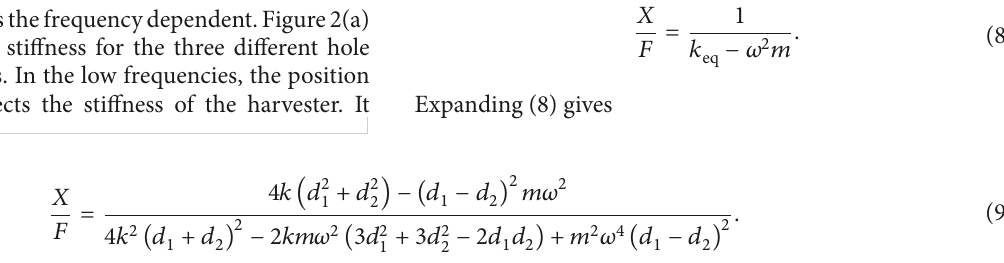
Substituting 𝐽 = (1/4)𝑚(𝑑 1 − 𝑑 2 ) 2 and (3) and (6) into